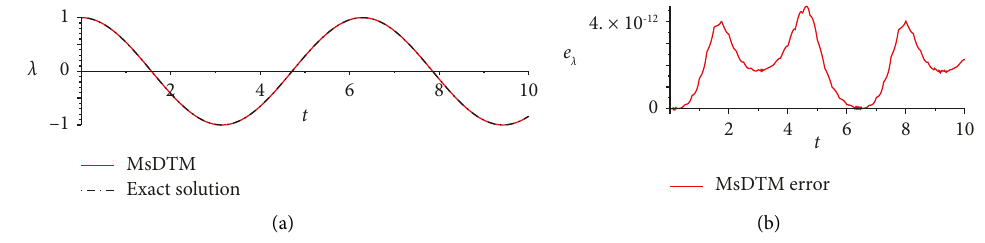
Figure 5: The approximate solution component λ (a) and the absolute error e